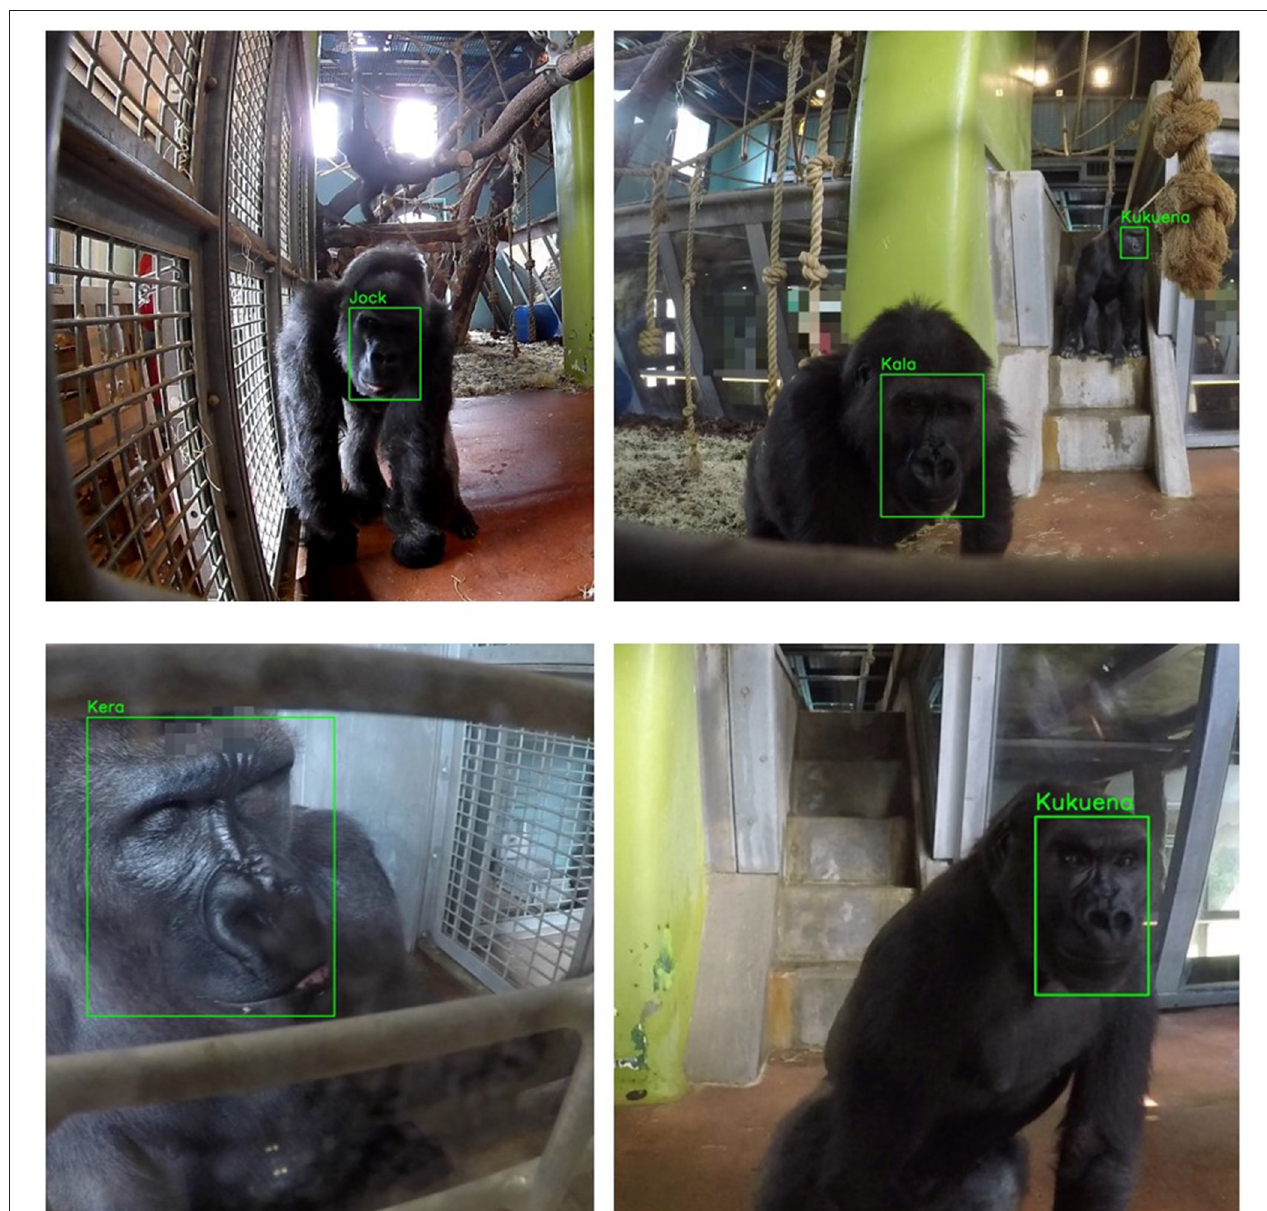
FIGURE 3 | Gorilla face annotation. The figure shows a collection of images that were annotated during the dataset generation process. The green boxes were manually annotated (or drawn) onto the images to indicate the location of the gorillas face. This was done by dragging a rectangle over the facial area from top-left to bottom-right. In these images the name of the gorilla (or class ) is shown for